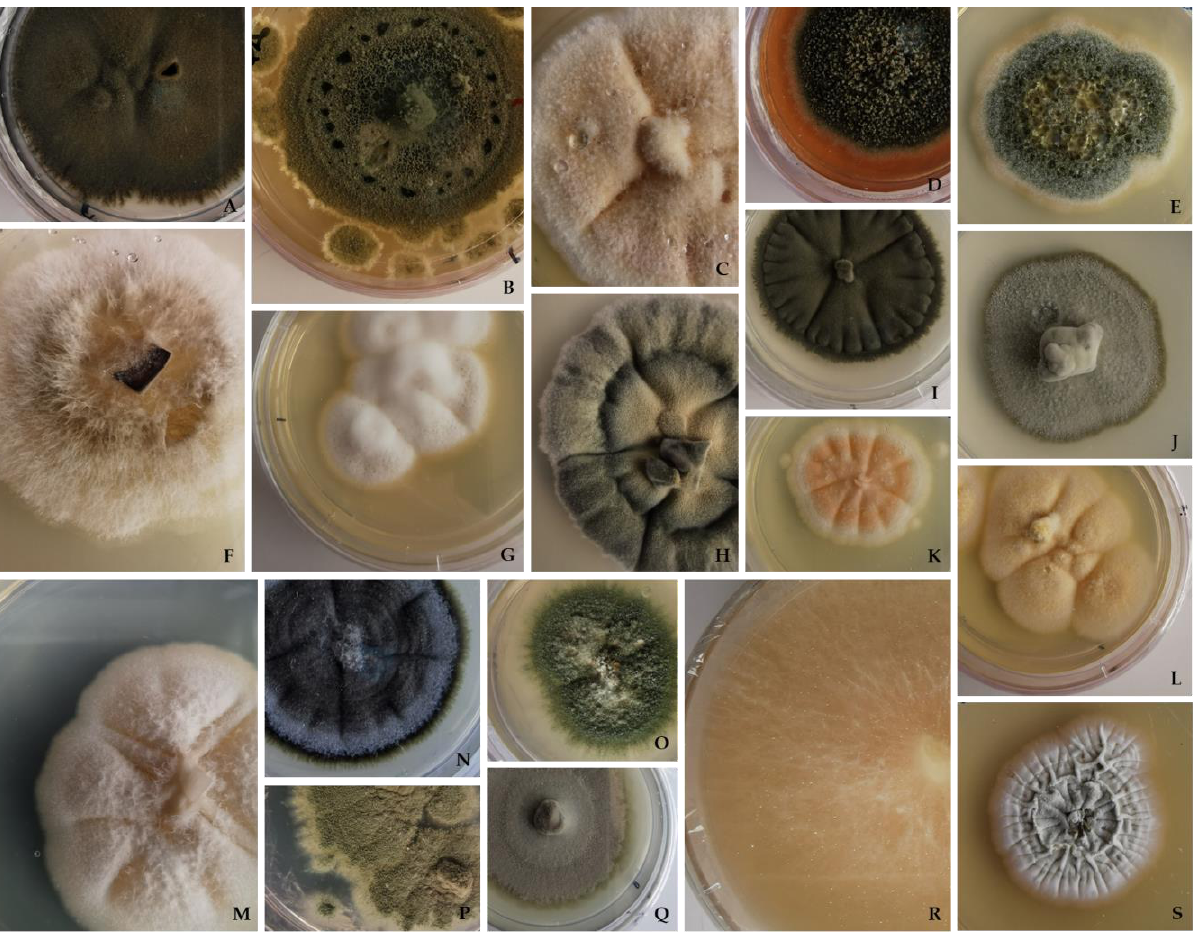
Figure 1. Macroscopic observations of some representatives of the fungal isolates obtained in this study on PDA medium: ( A , I ) Cladosporium allicinum . ( B ) Penicillium crustosum . ( C , E , L , O ) Aspergillus protuberus . ( D ) Stachybotrys chartarum . ( F ) Tapesia fusca . ( G ) Parengyodontium album . ( H ) Cladosporium cladosporioides . ( J , Q ) Cyphellophora olivacea . ( K , M ) Acremonium charticola . ( N ) Cladosporium sinuosum . ( P ) Penicillium brevicompactum . ( R ) Stereum hirsutum. ( S ) Filamentous Actinobacteria (fungus-like bacteria).